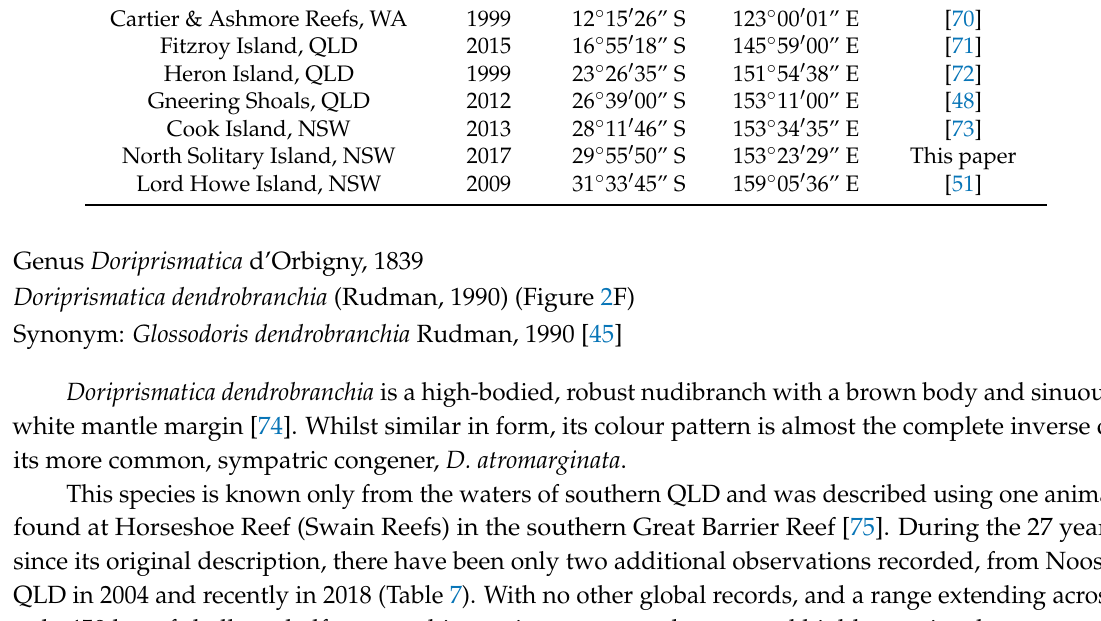
Table 6. Selected Australian distribution records of Chromodoris magnifica.